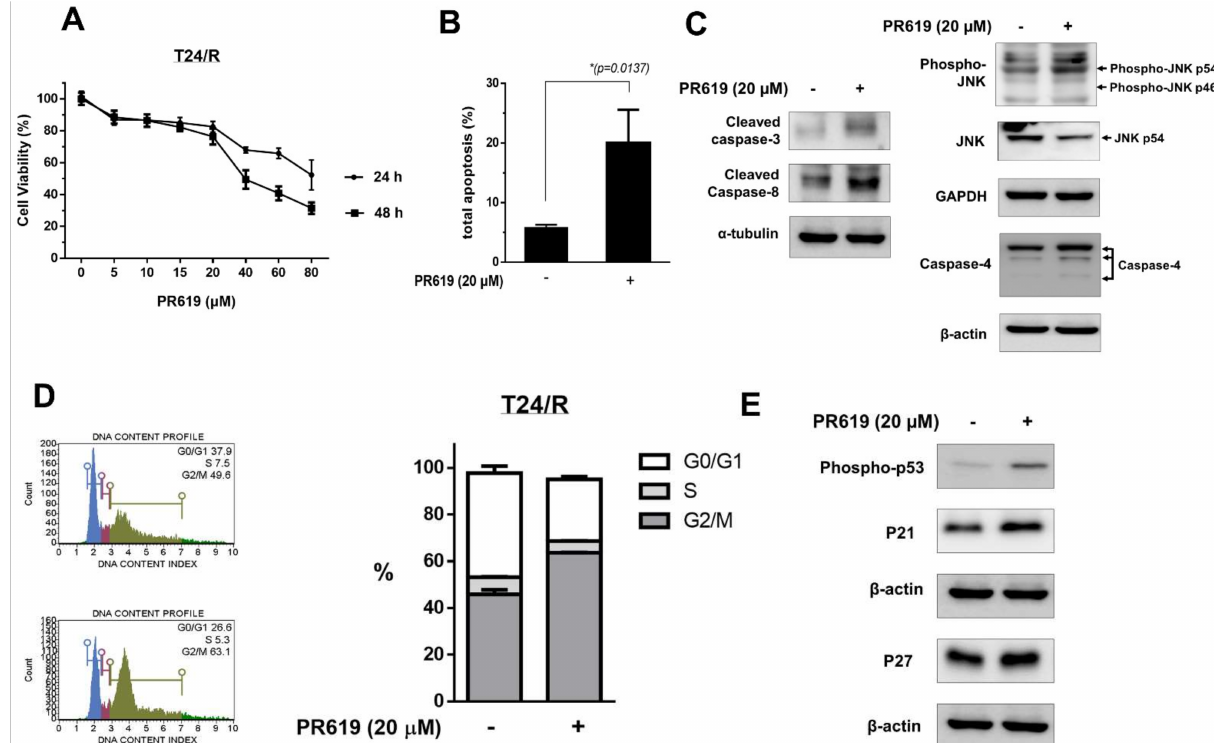
Figure 3. PR-619 effectively induces cytotoxicity, apoptosis, endoplasmic reticulum stress-related apoptosis, and cell cycle arrest in cisplatin-resistant human urothelial carcinoma (UC) cells (T24/R). ( A ) Cisplatin-resistant UC cell lines (T24/R) received mock treatment (dimethyl sulfoxide; DMSO) or various concentrations of PR-619 (10–45 µ M) for 48 h. Cell viability was assessed using the MTT assay. ( B ) T24/R cells were treated with PR-619 (20 µ M) or DMSO for 48 h. Apoptotic cells were analyzed using fluorescence-activated cell sorting with propidium iodide and Annexin V-FITC staining. Data are presented as means ± standard deviation; * p < 0.05 represents a significant difference between the indicated groups. ( C ) Cell lysates were harvested and Western blotting was performed with specific antibodies for the stress-related molecules, phospho stress-activated protein kinase/c-Jun N-terminal kinase (Thr183/Tyr185), and the ER stress-related apoptosis molecule caspase-4. The results are representative of at least three independent experiments. ( D ) PR-619 induces G2/M arrest in cisplatin-resistant human UC cells (T24/R). T24/R cells were treated with PR-619 (20 µ M) or DMSO for 48 h. The cell cycle progression was analyzed using flow cytometry with propidium iodide staining. Quantitative data are presented as means ± SD of independent experiments. * p < 0.05 was considered significant as compared with the control. ( E ) T24/R cells were treated with PR-619 (20 µ M) or DMSO for 48 h. The expression of cyclin-dependent kinase inhibitors p21 and p27 in total cell lysates was analyzed using Western blotting. The results are representative of at least three independent